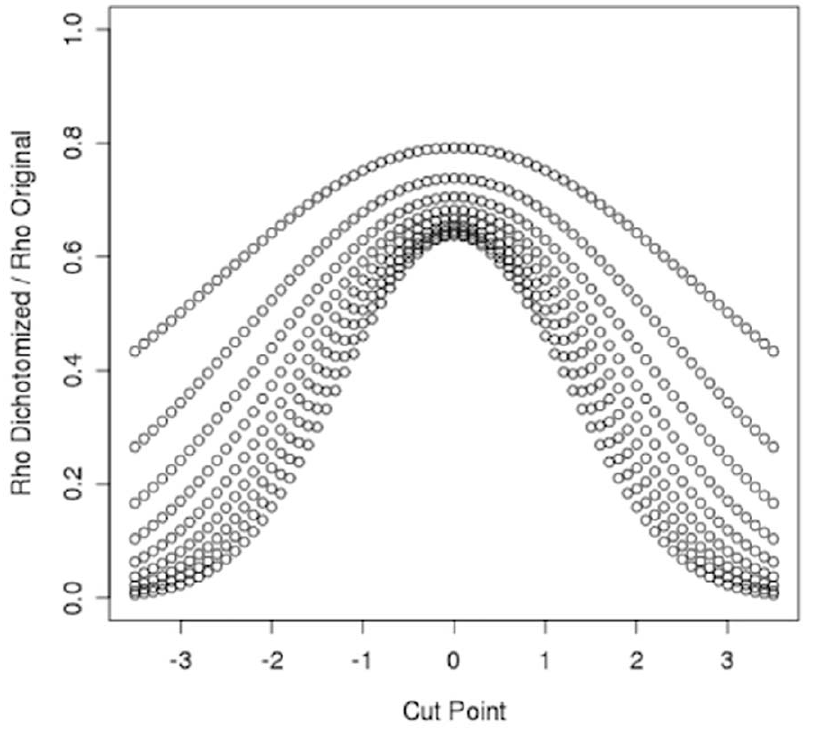
Figure 6. Affect of dichotomizing on the correlation between two normally distributed variables. Correlation between dichotomized variables compared to the original correlation between two normally distributed variables. Each curve represents an original correlation value ( r =0.1 for the bottom curve to r =0.9 for the top curve by 0.1). The same cut point was used for both variables. doi:10.1371/journal.pone.0040925.g006 PLoS ONE |